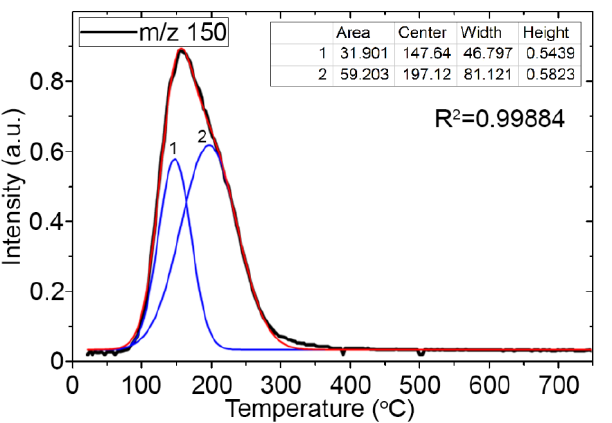
Figure 7. Deconvolution of the TPD-curve for the molecular ion of 4-vinylguaiacol with m/z 150 into separate Gaussians.